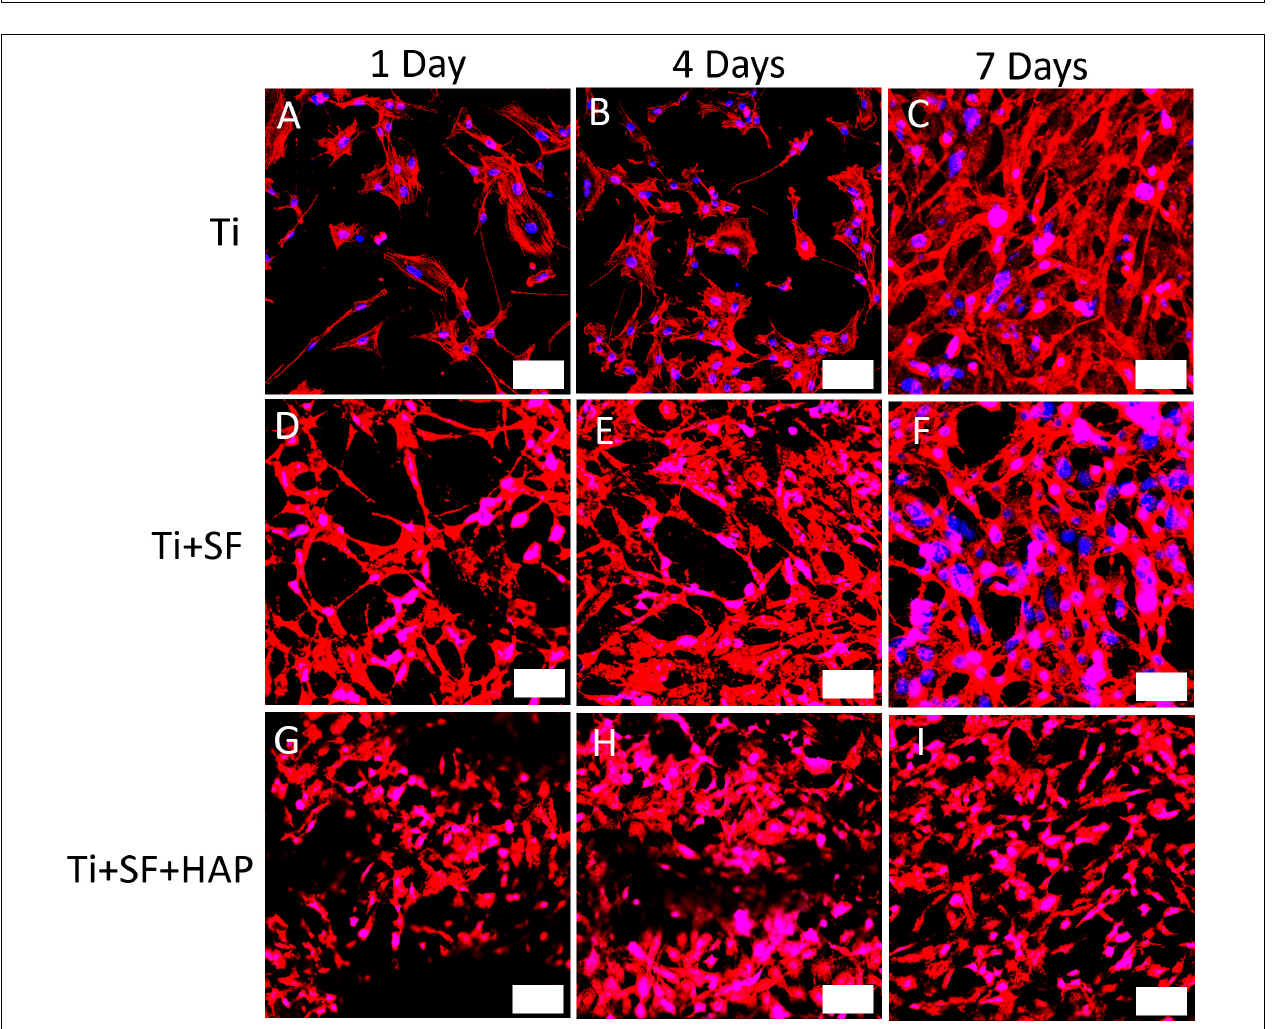
FIGURE 4 | CLSM observations for immunostaining MG-63 cells on three different testing materials: Ti (A–C) , Ti + SF (D–F) , and Ti + SF + HAP (G–I) after 1 d (A,D,G) , 4 d (B,E,H) , and 7 d (C,F,I) of cultivation. The bar indicates 50 µ m. Blue color shows the nucleus of MG-63 cells which was stained by DAPI and the red color demonstrates the F-actin which was stained with